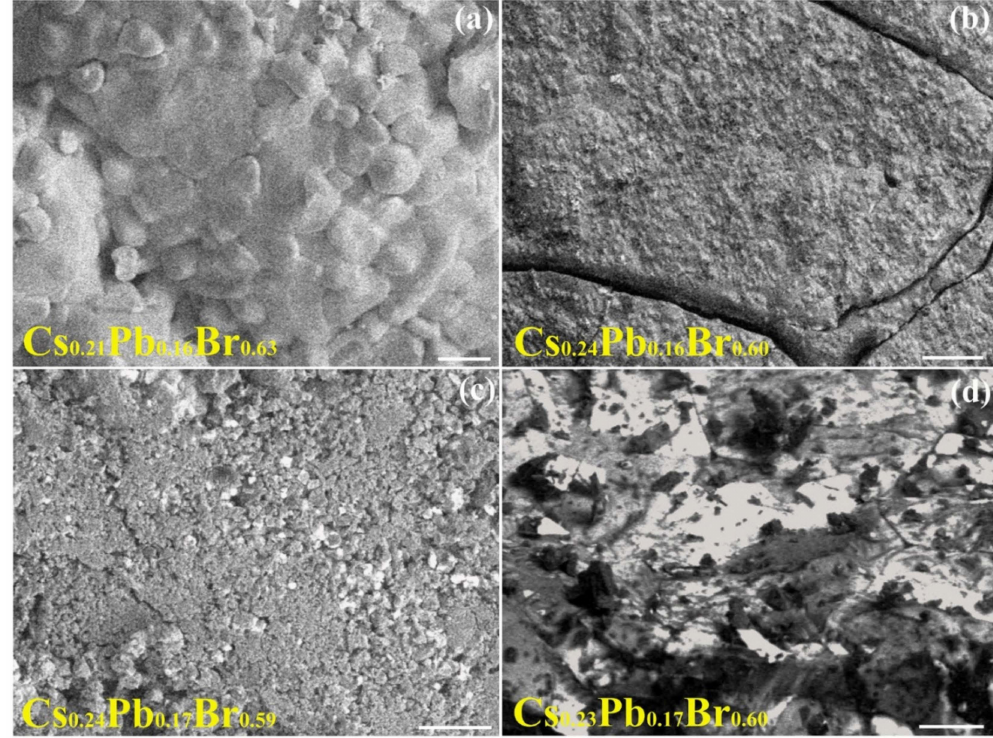
Figure 3. SEM images of the mechano-chemically prepared targets for increasing annealing temperature: ( a ) Target (300 ◦ C), ( b ) Target (400 ◦ C), ( c ) Target (500 ◦ C) and ( d ) Target (550 ◦ C). (Scale bars ( a – d ): 100 µ